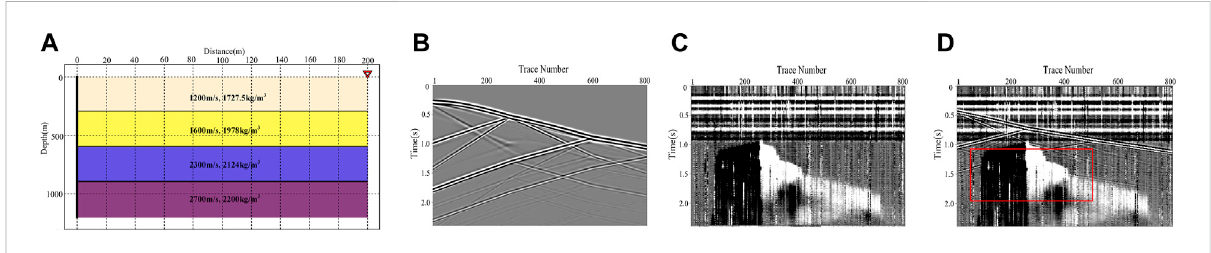
FIGURE 3 The generation of the noisy DAS data: (A) the forward model, (B) the clean synthetic record, (C) the added fi eld DAS background noise, and (D) the noisy synthetic record.